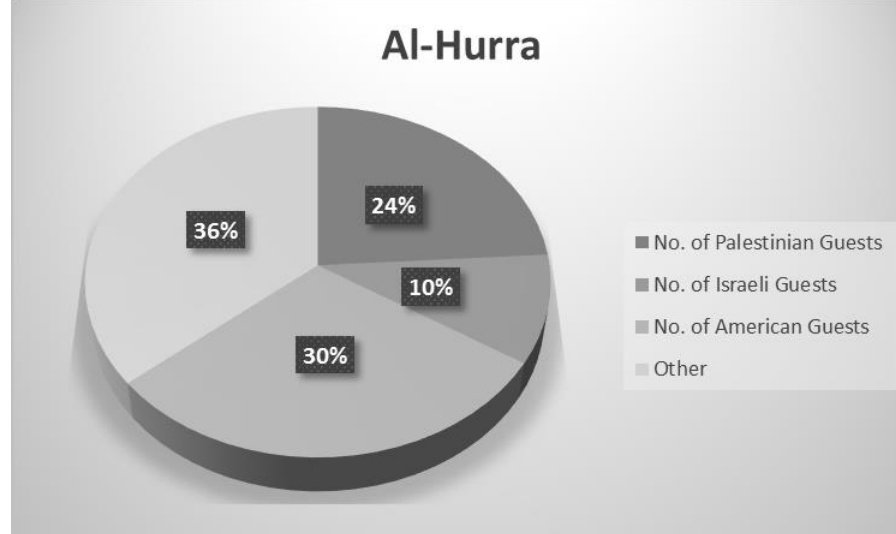
Figure 2. Representation of guests on Al-Hurra 's talk